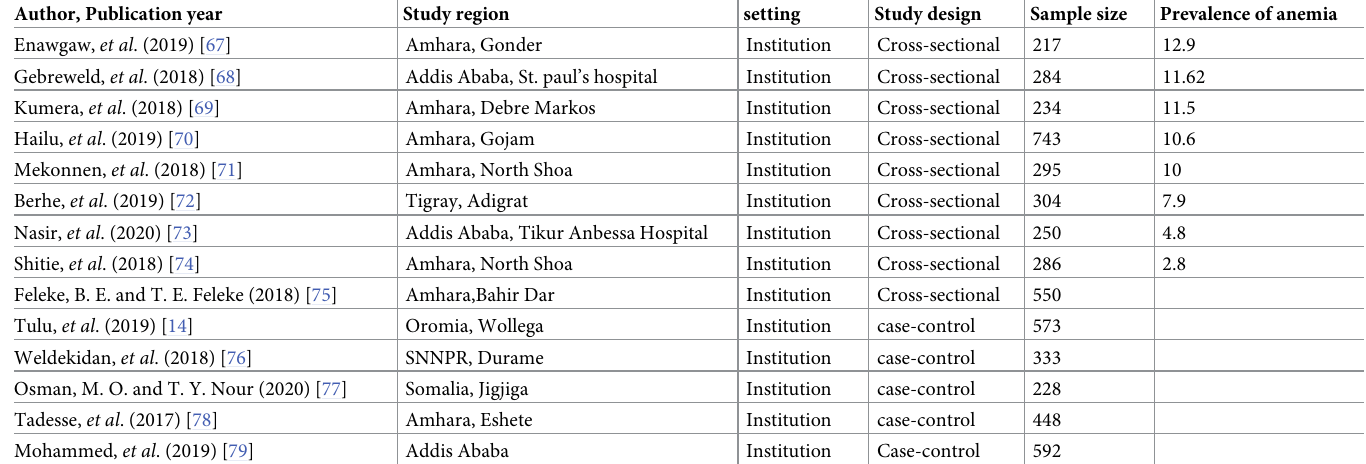
family of 5 and more members were more likely (RR = 1.62, 95% CI: 1.33, 1.96) to be anemic than women living with lesser family members. Married women were 63% less likely to develop anemia than unmarried women (Table 3). Obstetric factors. The meta-analysis showed that obstetric factors such as birth interval, gestational age, blood loss during pregnancy, antenatal clinic (ANC) follow up and history of excess menstrual bleeding were significantly associated with anemia during pregnancy ( p < 0.001). Birth interval less than 24 months had a higher risk for anemia on pregnancy than an inter- val greater than 24 months [14, 31, 34, 82]. In contrast to this, other studies reported birth interval had no statistically significant association with maternal anemia [62, 66, 74, 81, 83]. However, pooled risk ratio showed women who got pregnant within 24 months birth interval were more likely (RR = 1.55(95% CI; 1.31,1.83)) to be anemic than their counterparts. Due to statistically significant heterogeneity between studies, random effect analysis was used (Table 4). The pooled risk ratio from 34 studies showed women in the third trimester had a higher risk of anemia (RR = 1.19, (95% CI; 1.01, 1.32)) than those women in the first and second tri- mester. Women with no history of ANC visit were more likely (RR = 1.36, (95% CI; 1.04, 1.80)) to be anemic than those at ANC follow up. Women with a history of blood loss during pregnancy were nearly two times more at a risk of being anemic than those with no history of blood loss. History of excess menstrual bleeding is also positively associated with anemia dur- ing pregnancy. Random effect analysis was used due to significant heterogeneity between stud- ies, and Begg’s and Egger’s analysis showed there was no statistically significant publication bias as shown in Table 4. Dietary factors. Iron and folic acid supplementation . Women who did not take iron-folic acid during pregnancy were 1.53 times more likely to be anemic during pregnancy than those who took iron-folic acid regularly, RR = 1.53 (95% CI, 1.30, 1.81). Due to the presence of sig- nificant heterogeneity (I 2 = 85.7%, P < 0.001), random effect analysis has been used. Begg’s and Egger’s tests showed no statistically significant evidence for publication bias ( p = 1.00, p = 0.863 respectively) (Fig 3). Low dietary diversity . Women with low dietary diversity were more likely (RR = 2.61, 95% CI: 1.97, 3.48) to develop anemia during pregnancy in comparison to those women